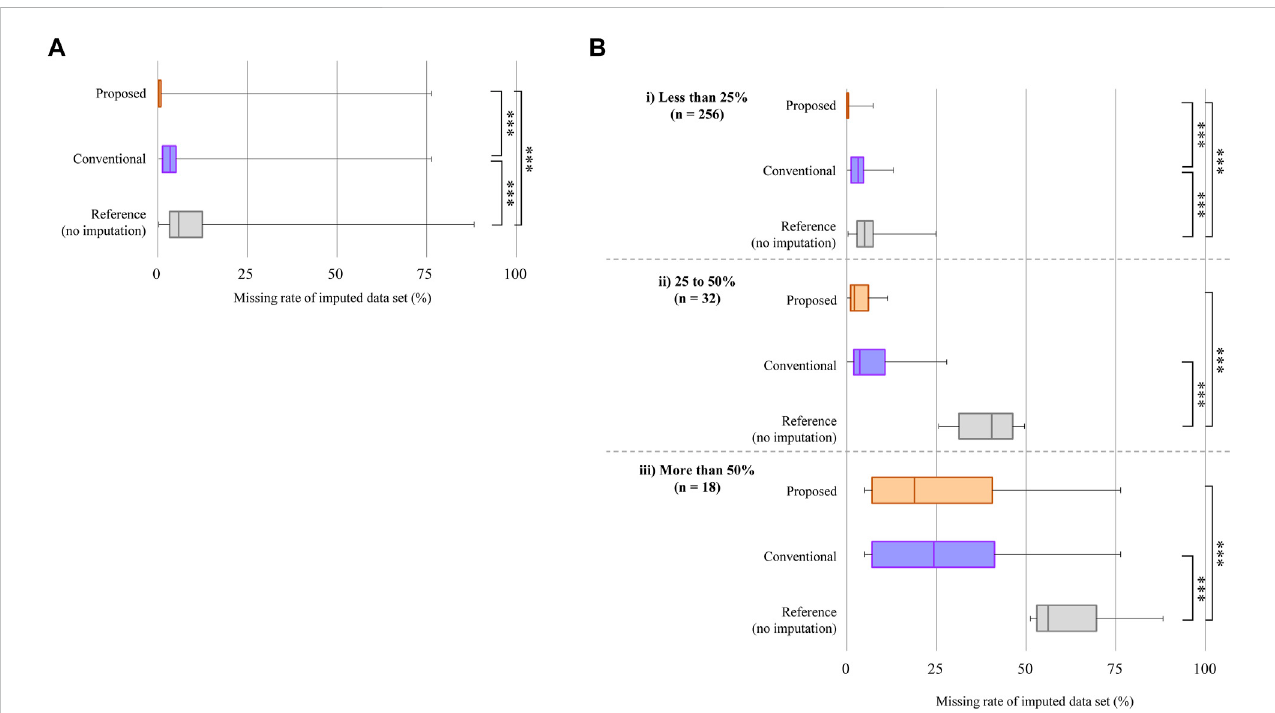
FIGURE 3 Comparisonofimputationsofdataloss. (A) Resultwithallmeasurementsamples( n =306).Theorangeboxatthetopshowsthemissingdataimputedby ensemble averaging (proposed method), the purple box in the middle shows that after selecting the day with the smaller missing data rate between the two measurement days (conventional method), and the gray box at the bottom shows the reference. The edges of the rectangle show the 75th and 25th percentiles. The median is the line inside the box. The median values are shown on each box. Whiskers show the maximum and minimum values. A Kruskal-Wallis test was used to con fi rm statistically signi fi cant differences between the three groups; ** p < .001. (B) Results of data imputation for different missing data rates without imputation. The horizontal axis shows the missing data rate after applying imputation methods. Kruskal-Wallis tests were used; ** p < .001, * p = .008.